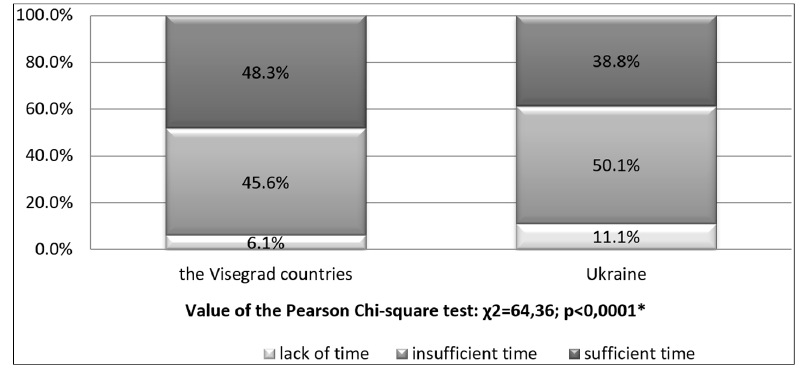
Figure 3. Amount of leisure-time in different countries. * Significant variation at p < 0.05.